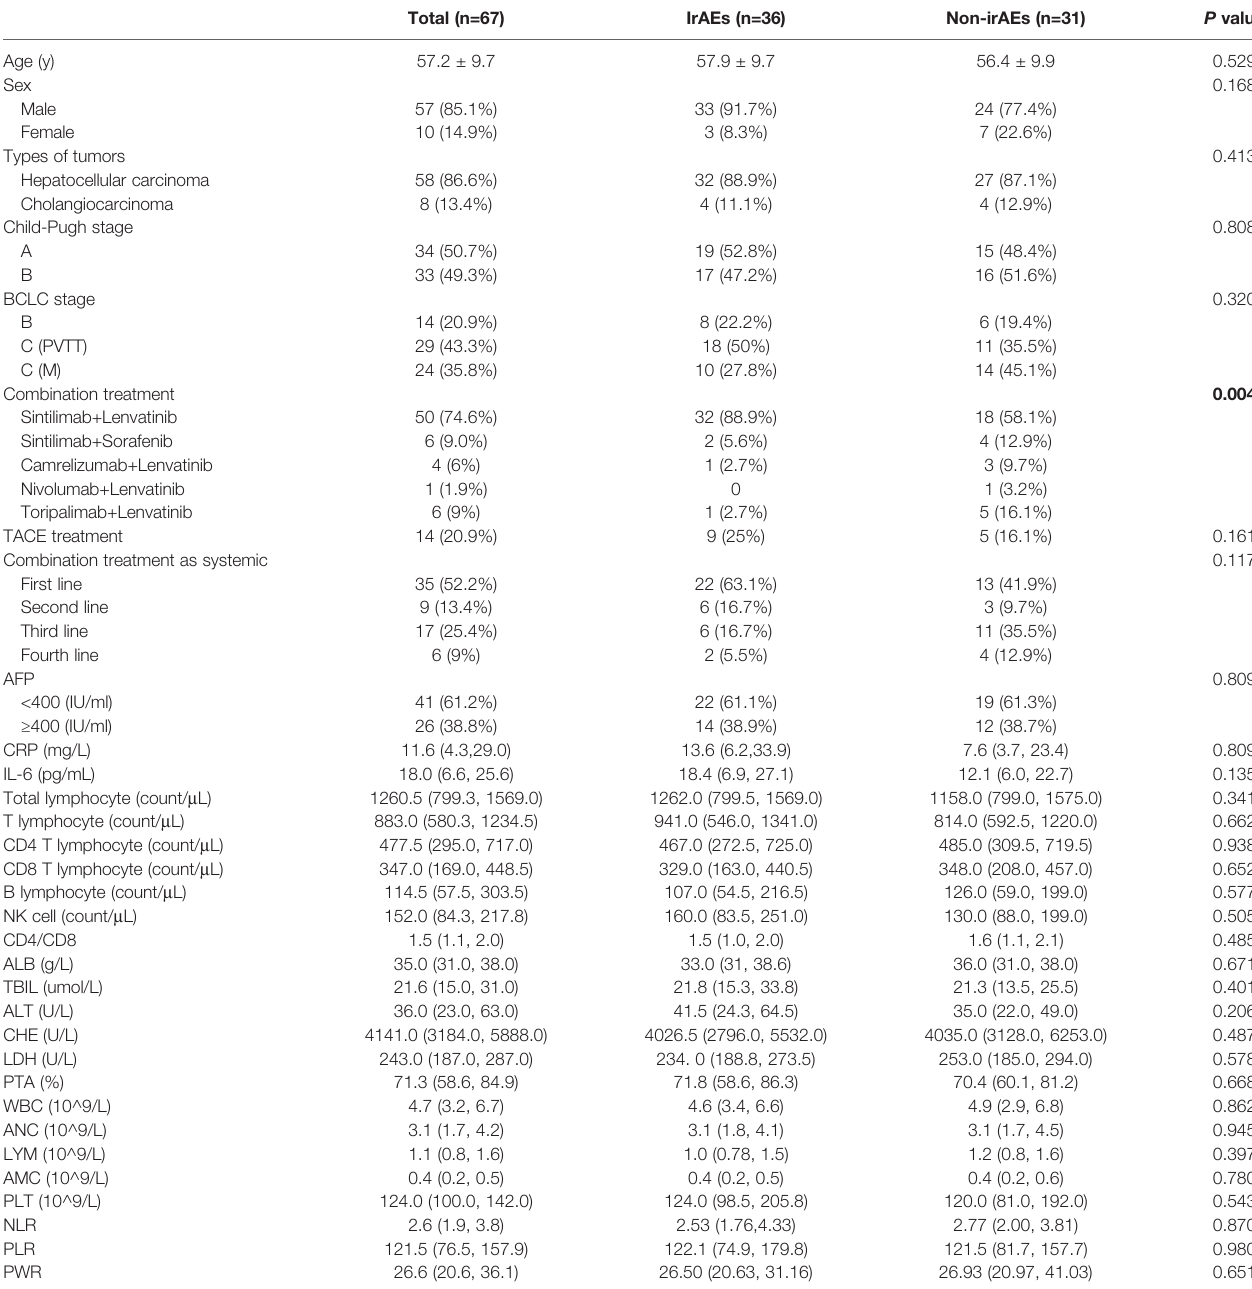
TABLE 1 | Comparison of baseline characteristics between patients with and without